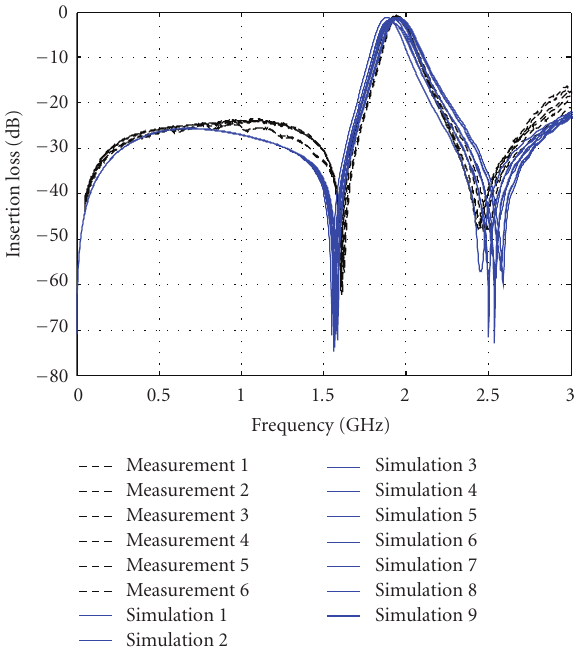
Figure 2: Comparison between measurement and